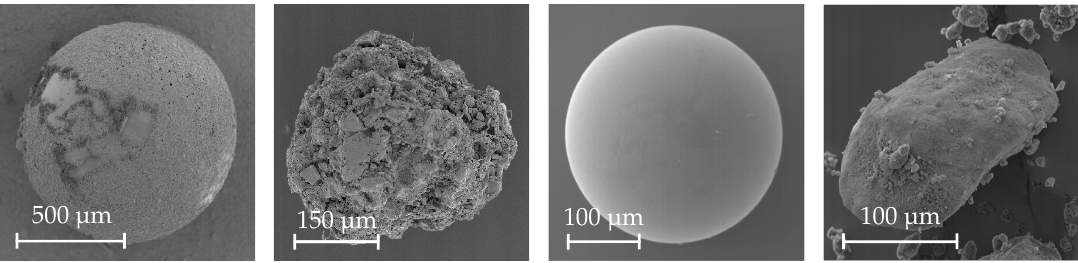
Figure 10. Images of the specimen that were used for the evaluation process. From left to right: Chalked Sphere (mag. 60, 2000 × 2000 px), Gravel Particle (mag. 150, 1000 × 1000 px), 300 µm Sphere (mag. 200, 2000 × 2000 px), DEP agglomerate (mag. 400, 2000 × 2000